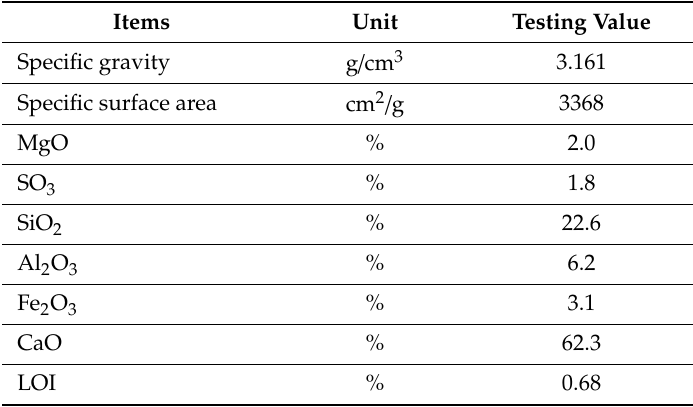
Table 1. Chemical compositions of ordinary Portland cement. Items Unit Testing Value Specific gravity g / cm 3 3.161 Specific surface area cm 2 /